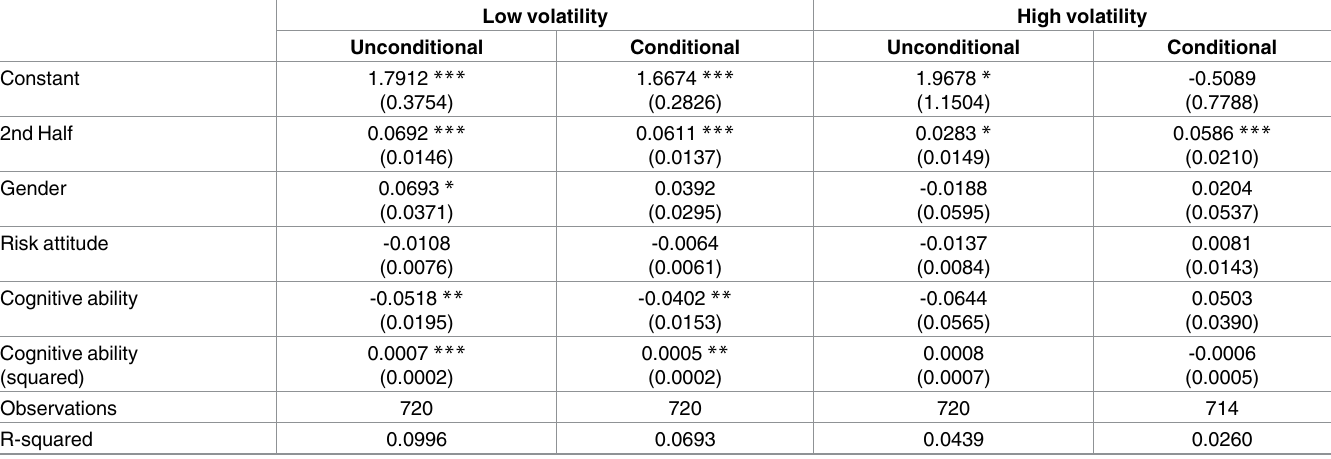
Table 3. Individual